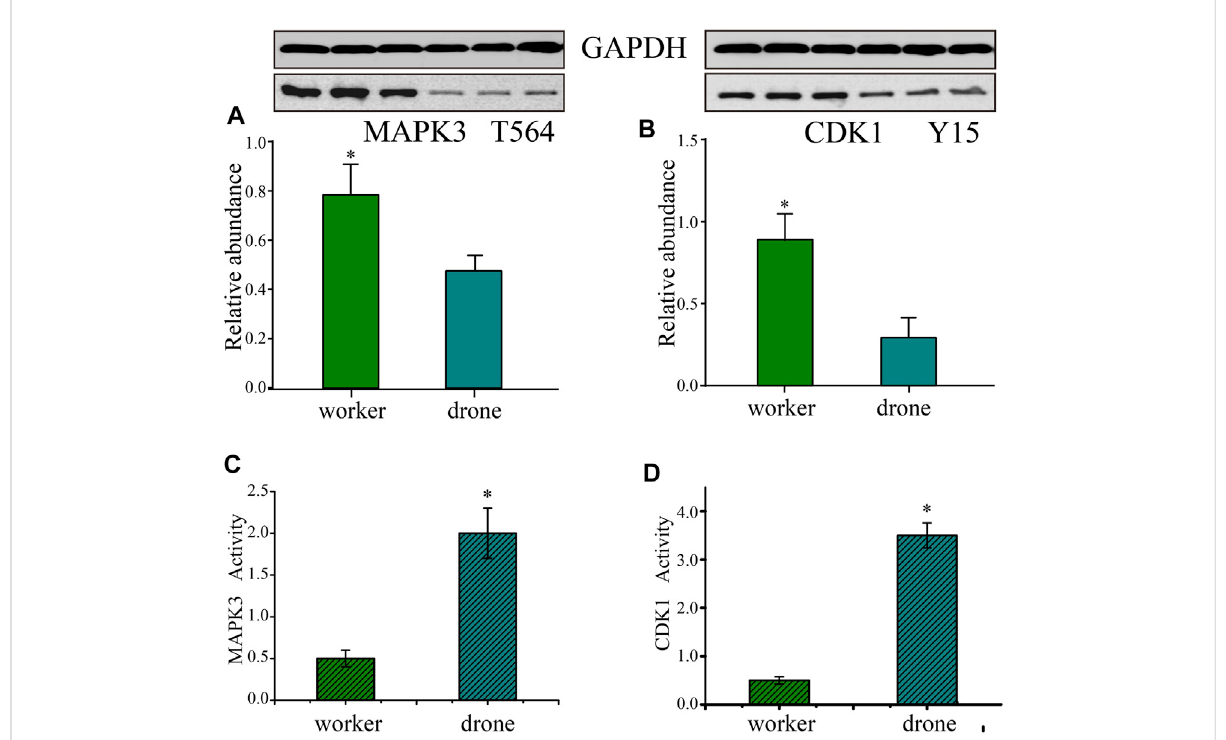
Validation of the kinases - Mitogen-activated protein kinase 3 (MAPK3) and Cyclin-dependent kinase 1 (CDK1). (A) Western Blotting analysis of theThr 564 siteinMAPK3 intheembryogenesis ofworker anddrone at24 h.GAPDHnormalizedtherelativeexpressionvalues ofthetarget peptidein thetwobees. (B) WesternBlottinganalysisoftheTyr 15 inCDK1inembryogenesisofworkeranddroneat48 h. (C) TheenzymaticactivityofMAPK3in embryogenesis of worker and drone at 24 h. (D) The enzymatic activity of CDK1 in embryogenesis of worker and drone at 48 h. The asterisk indicates a signi fi cant difference at p <